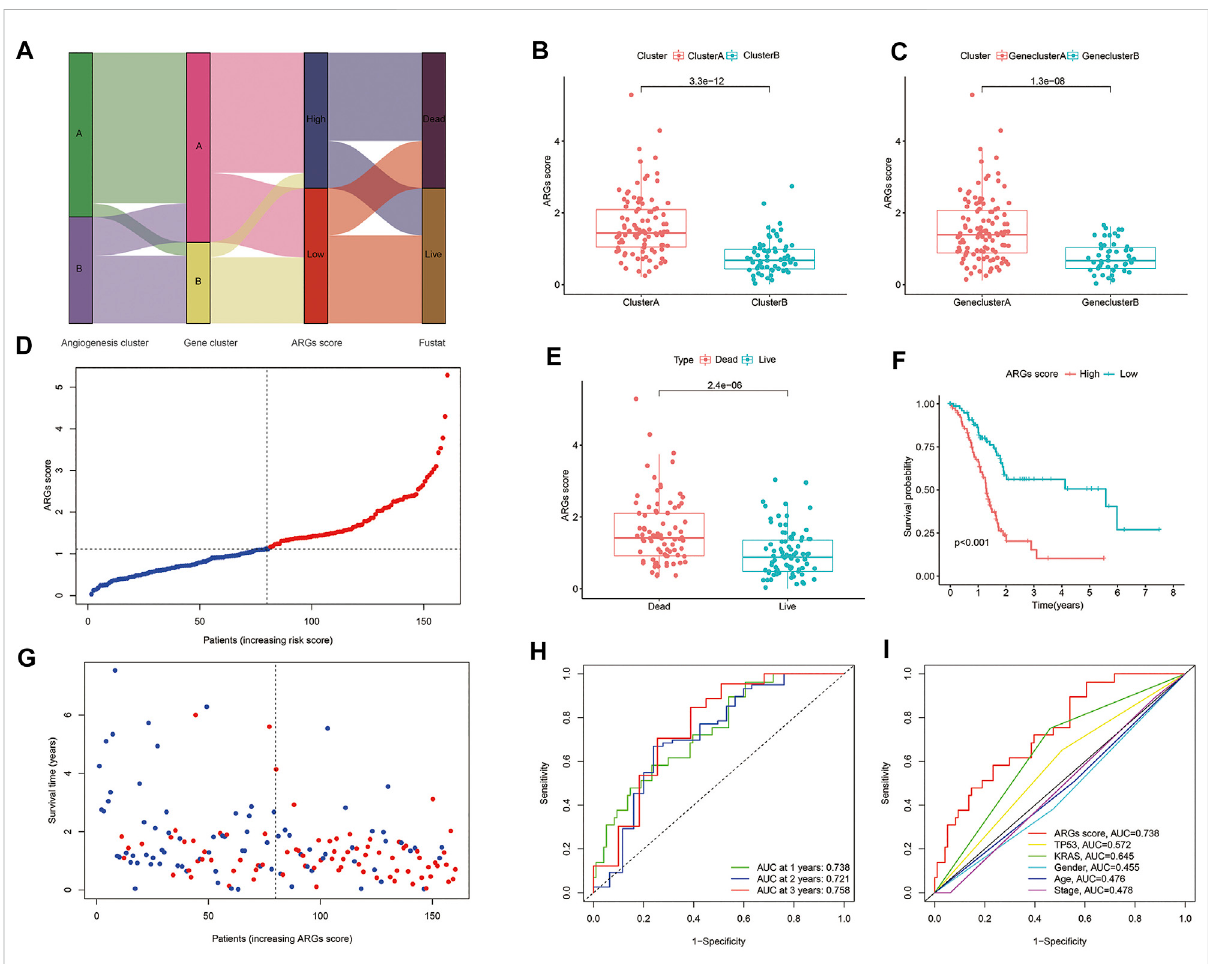
FIGURE 4 Construction of angiogenesis signature: (A) Sankey diagram of subtype distributions in groups with different ARGs scores and survival outcomes; (B) Differences in ARGs score between gene subtypes; (C) Differences in ARGs score between angiogenesis clusters; (D,G) Ranked dot and scatter plots showing the ARGs score distribution and patient survival status; (E) ARGs score was signi fi cantly elevated in dead patients; (F) Kaplan-Meier curves were used to analyze the survival of patients with high- and low- ARGs score in PC patients; (H) ROC curves were used to predictthesensitivityandspeci fi cityof1-,2-and3-yearsurvivalaccordingtotheARGsscore; (I) tROCcurvesofthenomogramscomparedfor1-,2- and 3-year OS in PC,